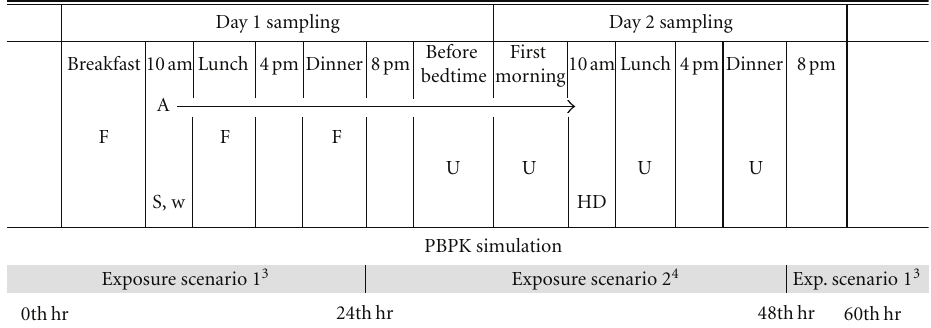
Figure 1: Sampling schedule for the 1998 study 1 and the corresponding PBPK model simulation 2